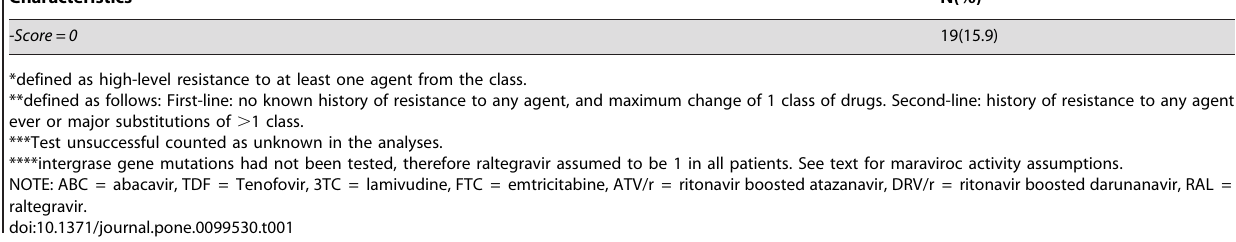
Characteristics